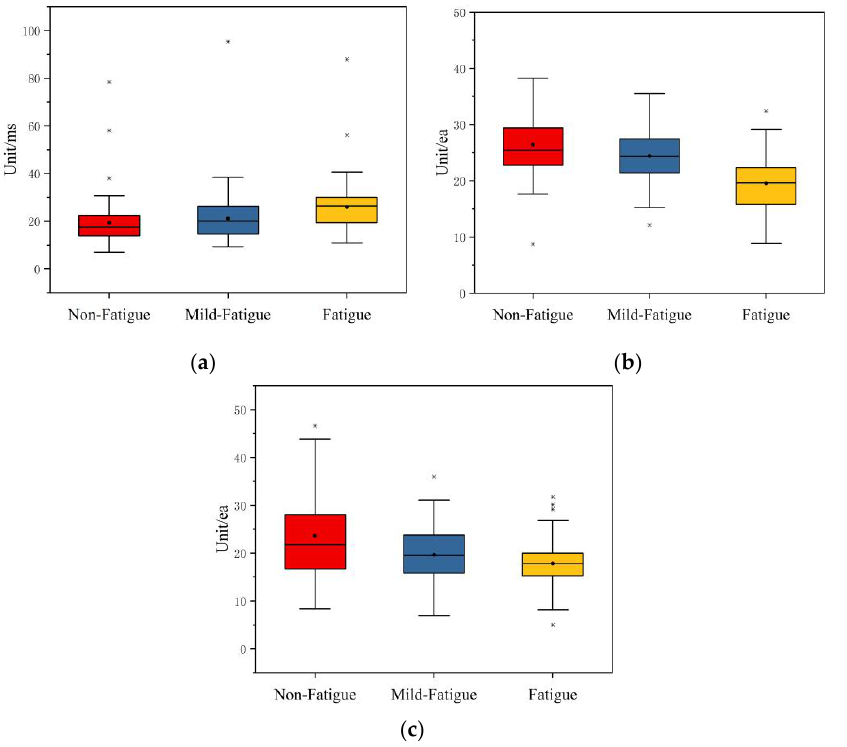
Figure 12. The boxplot of the non-linear indexes after feature selection. ( a ) The boxplot of SD1. ( b ) The boxplot of A++. ( c ) The boxplot of B++.